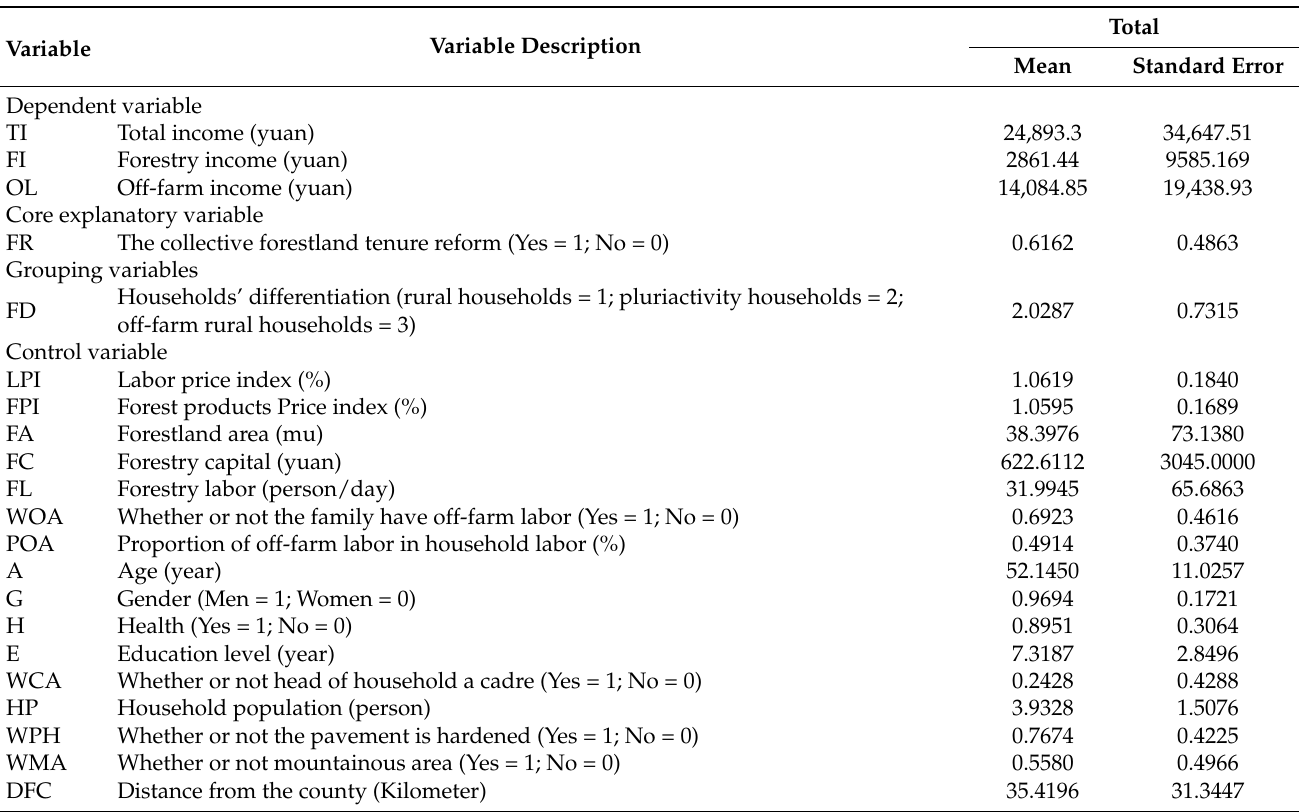
Table 1. Definition, assignment, and statistical description of the main